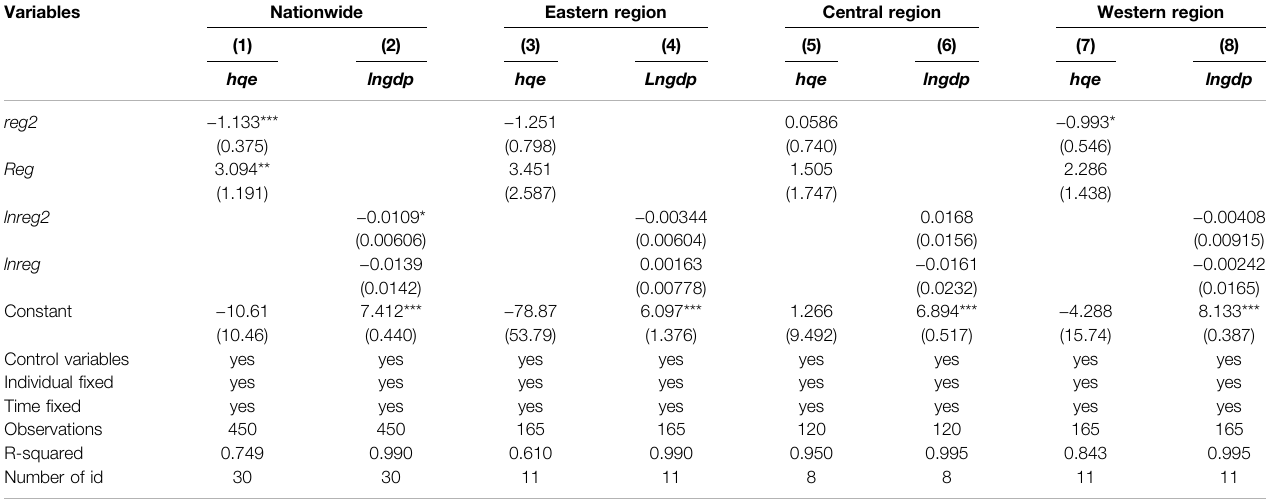
TABLE 8 | The results of empirical